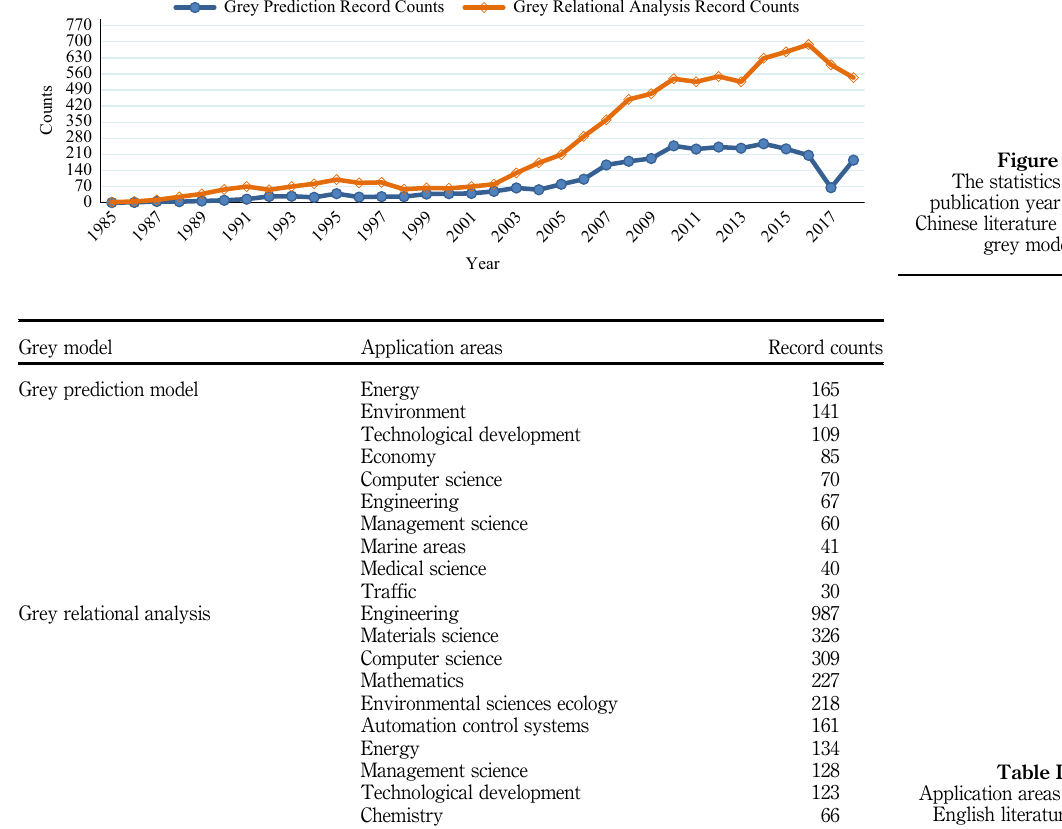
Figure 2. The statistics of